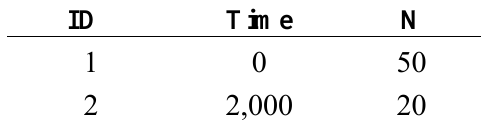
Table1 Predefined adjustment tables for N.